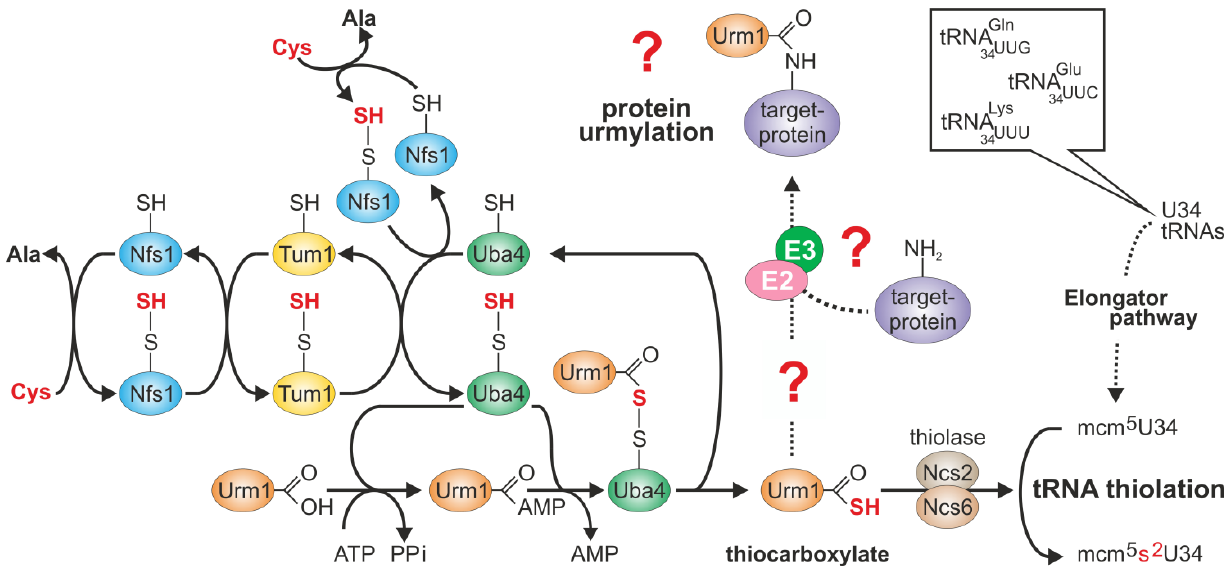
FIGURE 1: Sulfur flow within the URM1 pathway. The scheme depicts sulfur (red) flow and URM1 pathway players required for mobilization (Nfs1), transfer (Tum1), activation (Uba4, Urm1) or consumption (Ncs2•Ncs6) of sulfur. E1-like activator Uba4 (green) is key to